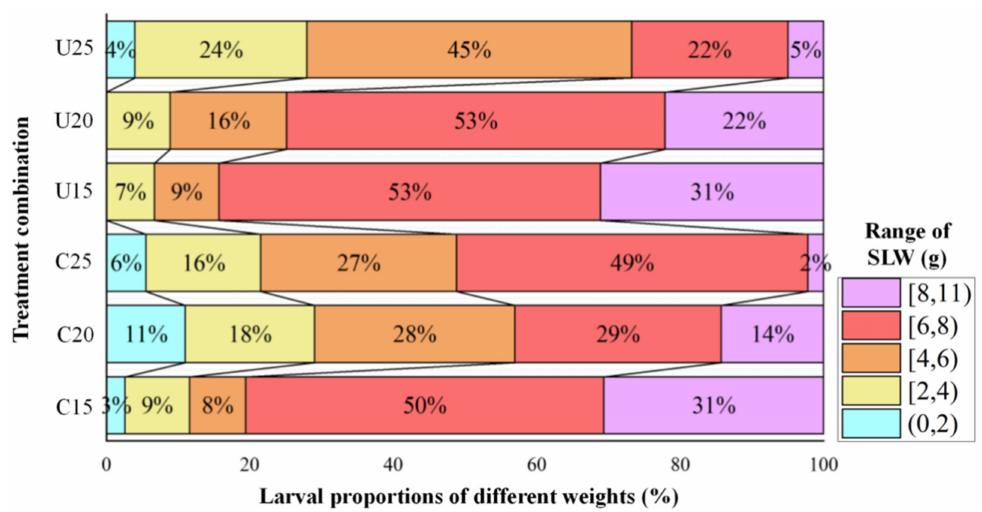
Figure 4. Interval distribution of single larval weight of different rearing treatments of NN89-29 in autumn sowing. U25, U20 and U15 are without plastic films on top of the net houses, with 25 eggs/m 2 , 20 eggs/m 2 and 15 eggs/m 2 , respectively. C25, C20 and C15 are with plastic film covering the net houses, with 25 eggs/m 2 , 20 eggs/m 2 and 15 eggs/m 2 , respectively. The legend numbers on the right-side refer to the range of single larval weight. The blue, yellow, orange, red and purple color blocks represent single larval weight of (0, 2) g, [2, 4) g, [4, 6) g, [6, 8) g and [8, 11) g, respectively.